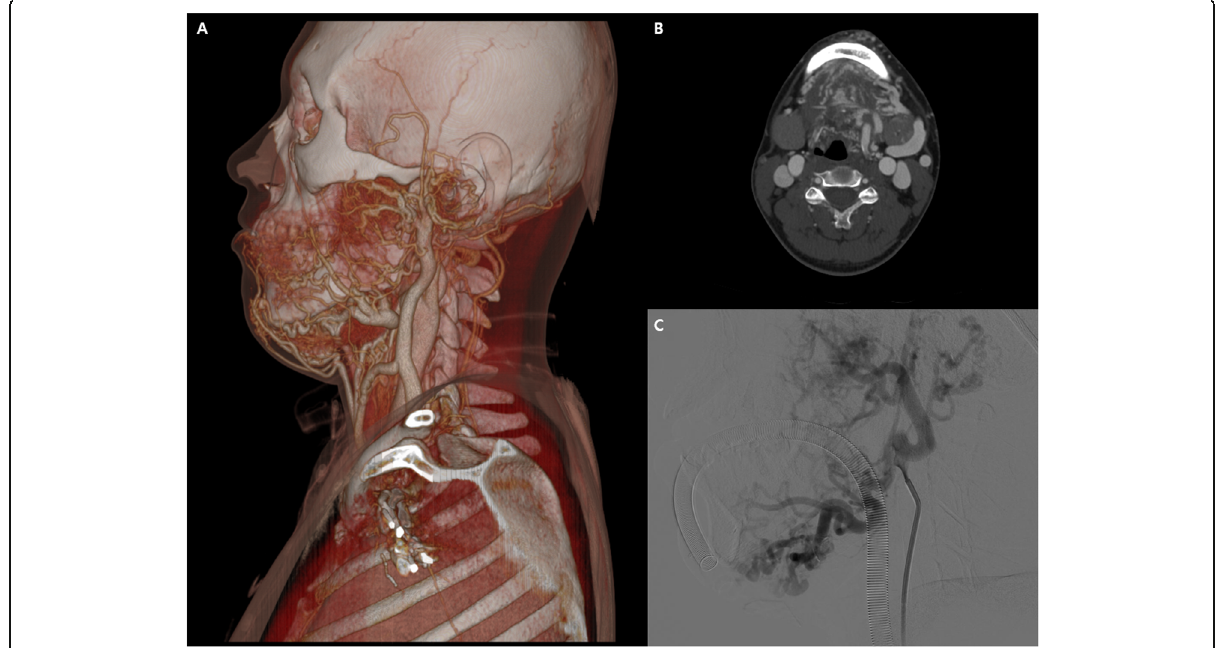
Fig. 1 Volume-rendered image ( A ) and axial image ( B ) of CT angiography show huge AVM involving the left side of his face, jaw, tongue, neck, and left ear. C Initially performed external carotid artery angiography reveals a very large AVM, which has multiple shunts between the arterioles and venules with dilated (Fig. 1 C), according to the Cho classification (Cho et al. 2006).